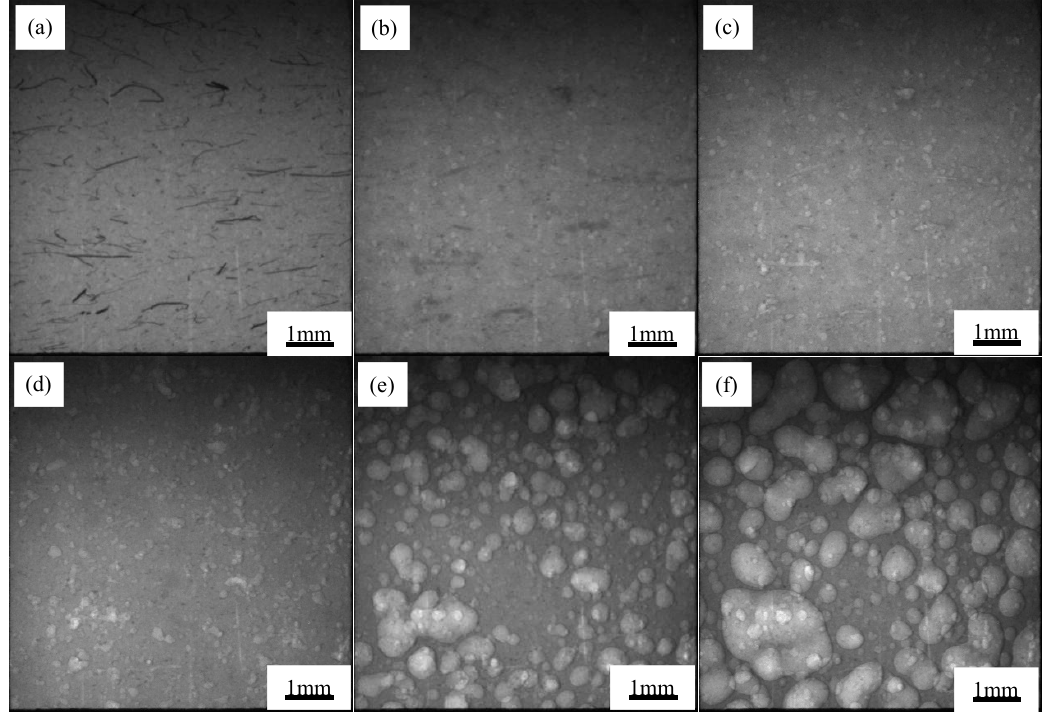
Figure 2. Foaming process of the aluminum foam with additional 0.5 wt.% C f : ( a ) <580 °C; ( b ) 590 °C; ( c ) 610 °C; ( d ) 652 °C; ( e ) 660°C; and ( f ) 663 °C.